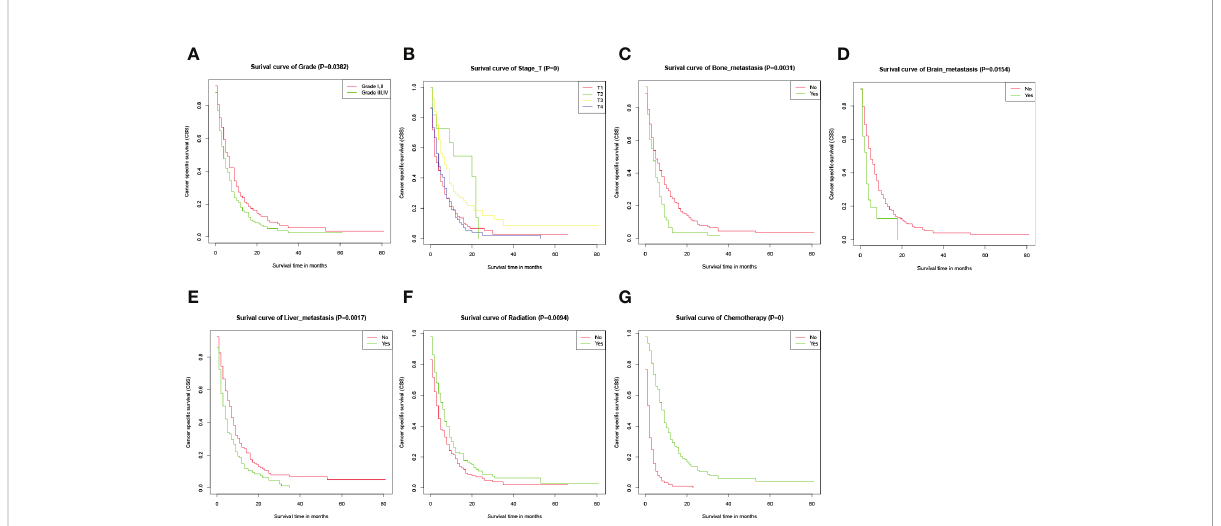
FIGURE 2 Kaplan-Meier CSS curves for several potential variables with P<0.05. (A-G) Kaplan-Meier curve of CSS based on grade, T-stage, bone metastasis, brain metastasis, liver metastasis, radiation, and chemotherapy respectively. The P-values are from a log-rank test for the comparison of the Kaplan-Meier curves.